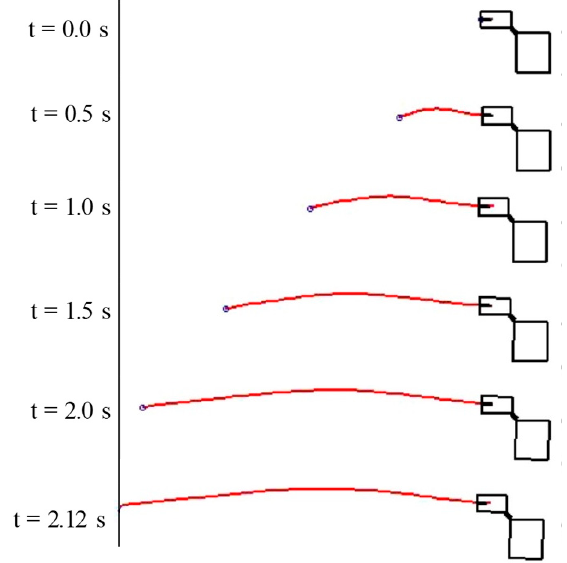
Figure 17. Shape of the system during tether extension (without control).